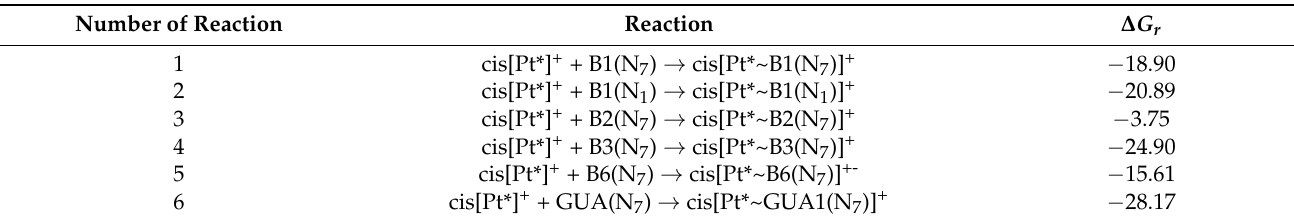
Table 1. The energetic characteristics of the cis-Pt-Chloroaqua reactions with derivatives of vitamin B. All energies are given in kcal/mol. Symbol Pt* stands for Pt(NH 3 ) 2 Cl [33]. Number of Reaction